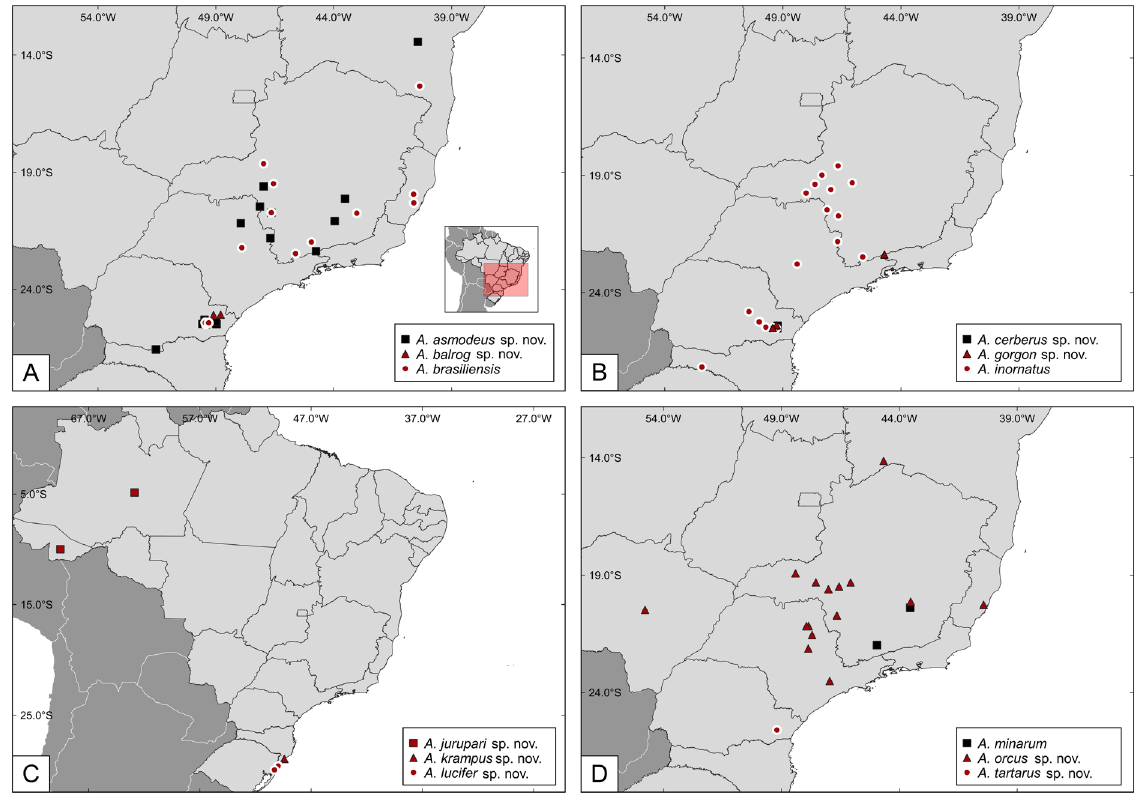
Fig. 10. Geographic records map. A . Austrosphecodes asmodeus sp. nov., A . balrog sp. nov., A . brasiliensis (Schrottky, 1910). B . A . cerberus sp. nov., A gorgon sp. nov., A . inornatus